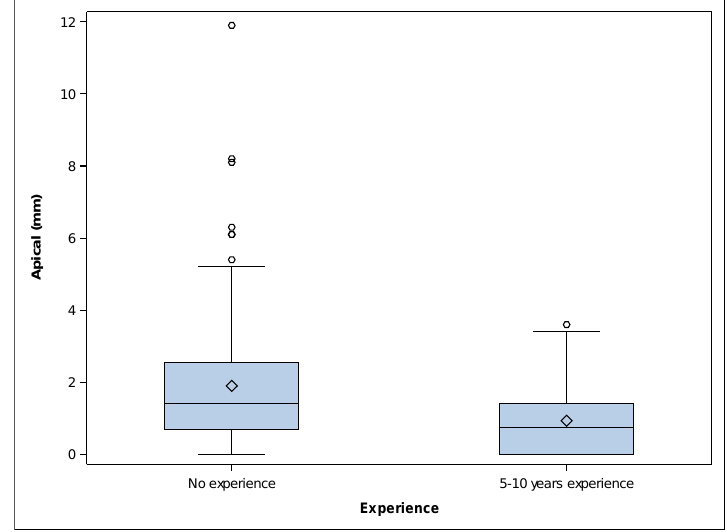
Figure 4. Box plots of apical deviations of the experimental groups. The horizontal line in each box represents the median value.